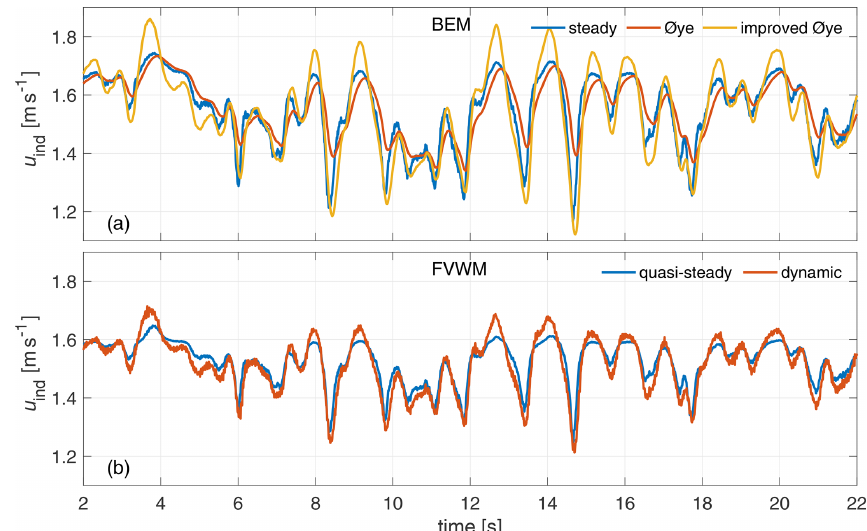
Figure A2. Steady and dynamic induced velocity at 0 . 6 R for the stochastic gust for BEM simulation with the original and improved Øye dynamic inflow model (a) and FVWM simulation (b) .